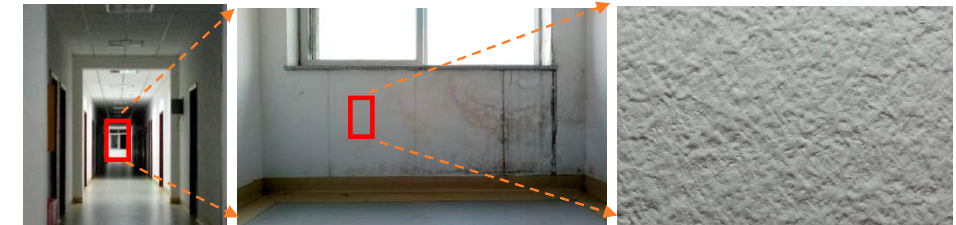
Figure 2. The white painted wall at the end of the corridor works as target.